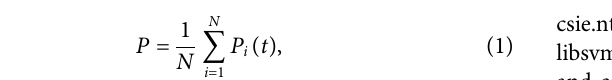
Frontiers in Earth Science |